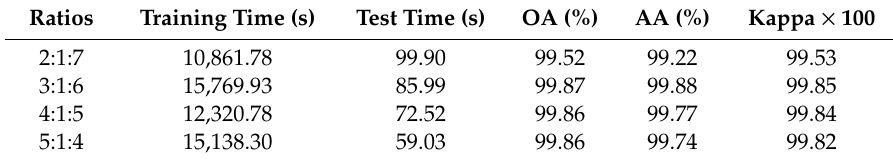
Table7. Trainingtime, testtime, andOAunderdi ff erentratiosontheINdatasetbytheproposedmethod. Ratios Training Time (s)